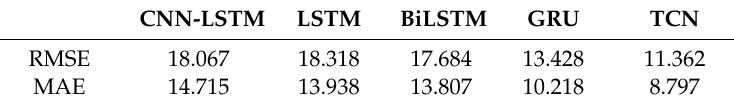
Table 3. Di ff erent models for prediction of heating zone